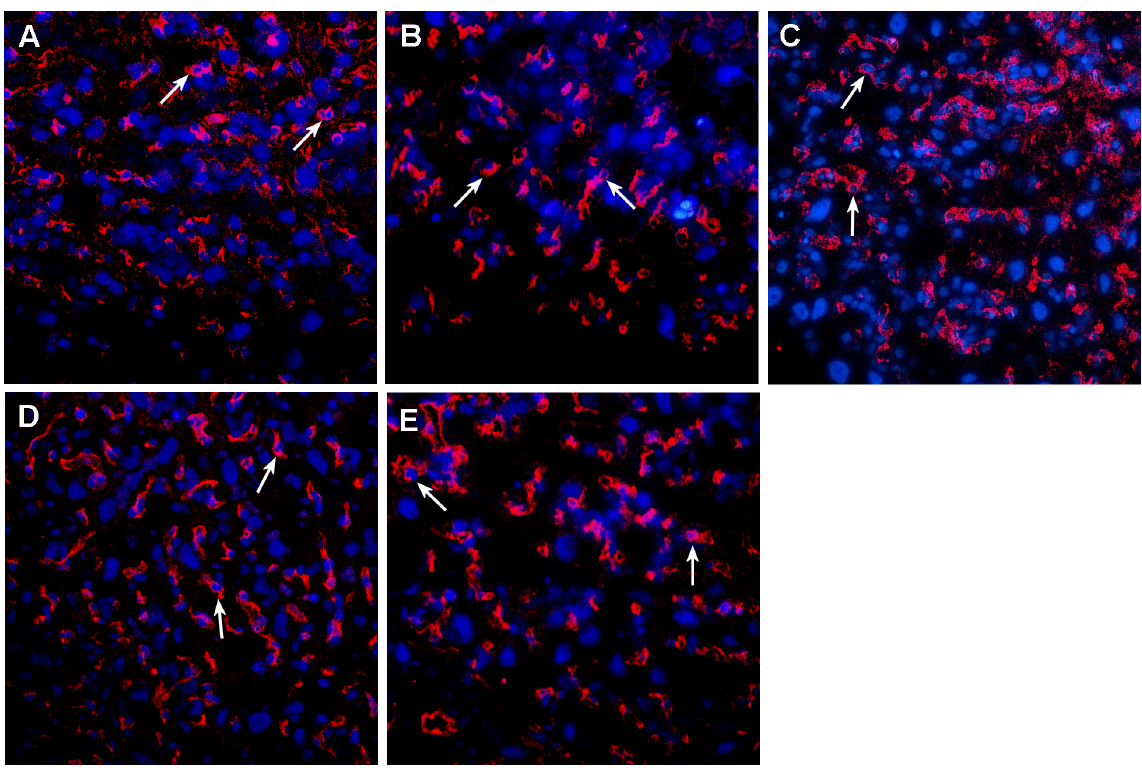
Figure 5. Expression of CD31 in the placental labyrinth zone from the control (A), 1.6 mg/kg bw ITE (B), 8.0 mg/kg bw ITE (C), 1.6 m g/kg TCDD group (D) and 8.0 m g/kg TCDD group (E). The tissue sections were probed with CD31 and countered with DAPI. Arrows indicate fetal capillaries in the trophoblastic septa. Magnification 6 200.